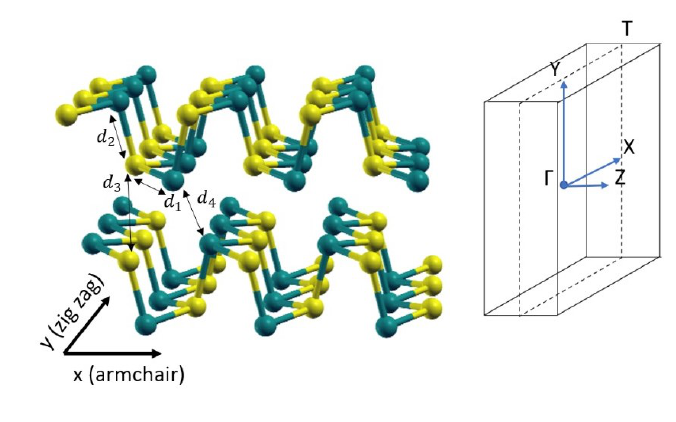
Figure 3. GeS crystal structure (Ge yellow, S blue) on the left and its Brillouin Zone on the